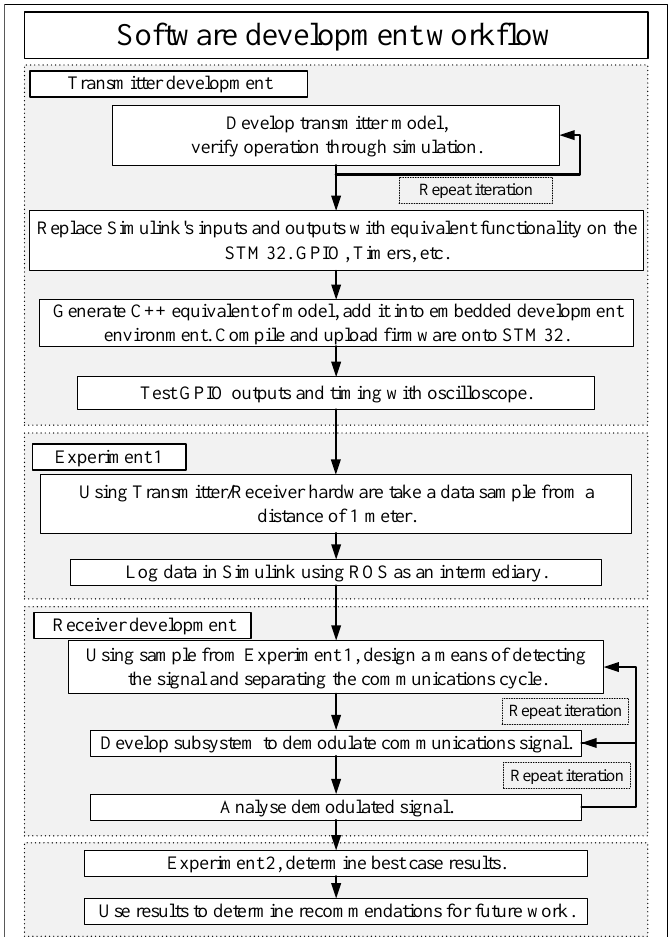
Figure 4. Software development workflow